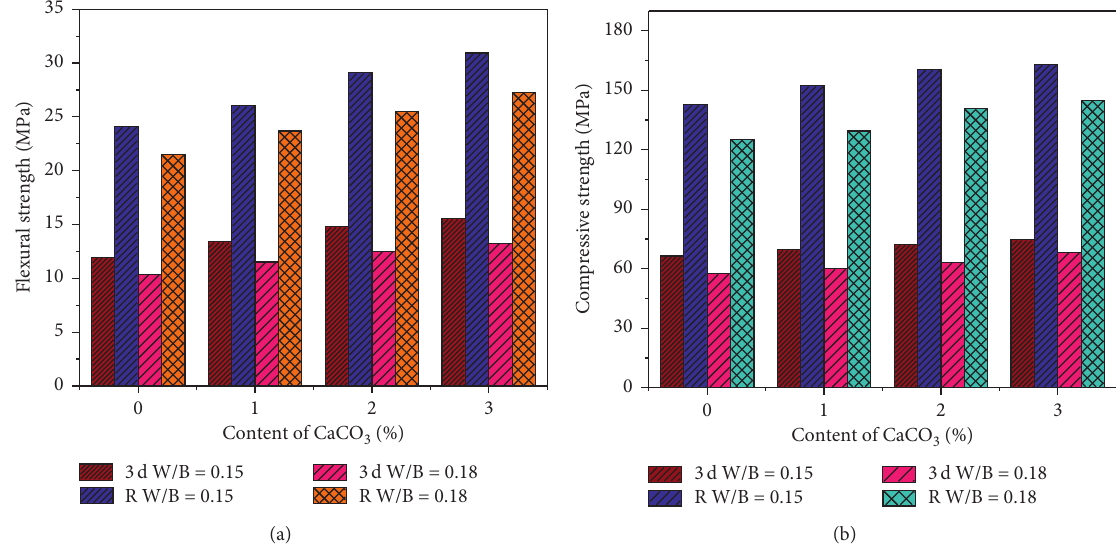
Figure 14: Influence of nano-CaCO 3 content on the (a) flexural strength and (b) compressive strength